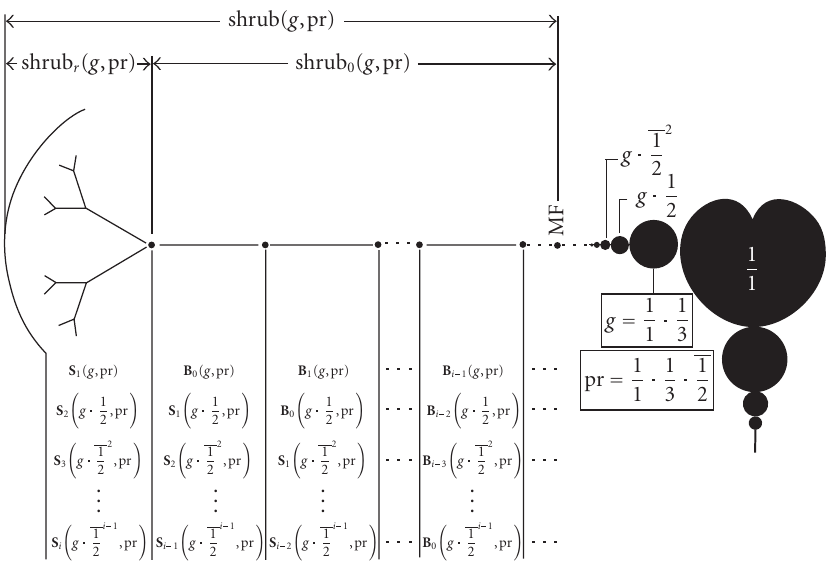
Figure 4.1. Sketch of the primary route through the primary hyperbolic component 1 / 1 · 1 / 3, show- ing the periodic route and the two parts of the chaotic route, shrub 0 (1 / 1 · 1 / 3,1 / 1 · 1 / 3 · 1 / 2) and shrub r (1 / 1 · 1 / 3,1 / 1 · 1 / 3 · 1 / 2). The lower part shows a table with di ff erent names of each chaotic